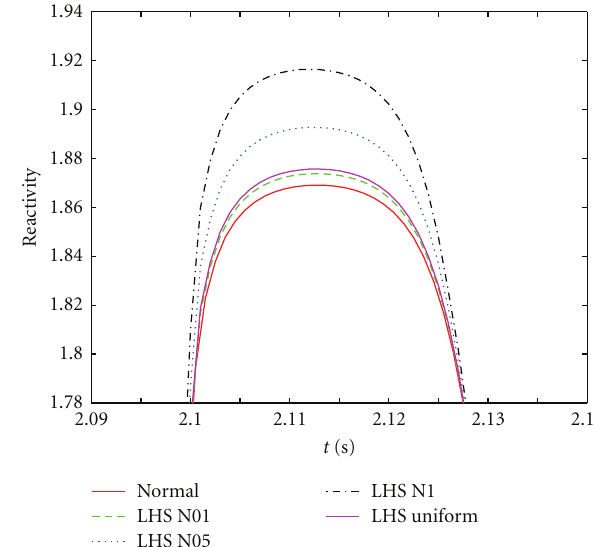
Figure 16: Reactivity upper tolerance limit (UTL) for LHS sampling